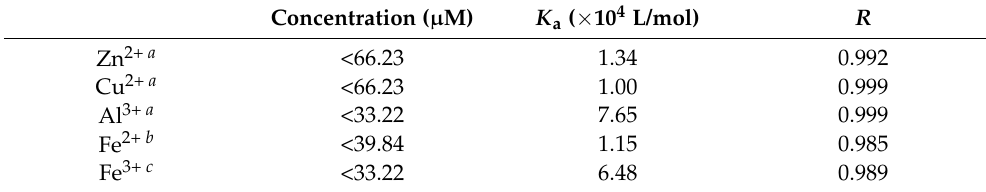
Table 2. Stern–Volmer constants ( K a ) describing PCT fluorescence quenching by metal ions at pH 6.0. Concentration ( µ M) K a ( × 10 4 L/mol) R Zn 2+ a <66.23 1.34 0.992 Cu 2+ a <66.23 1.00 0.999 Al 3+ a <33.22 7.65 0.999 <39.84